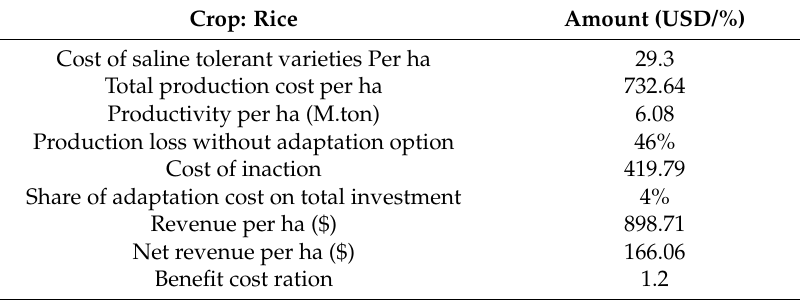
Table 4. Economic analysis of saline tolerant rice